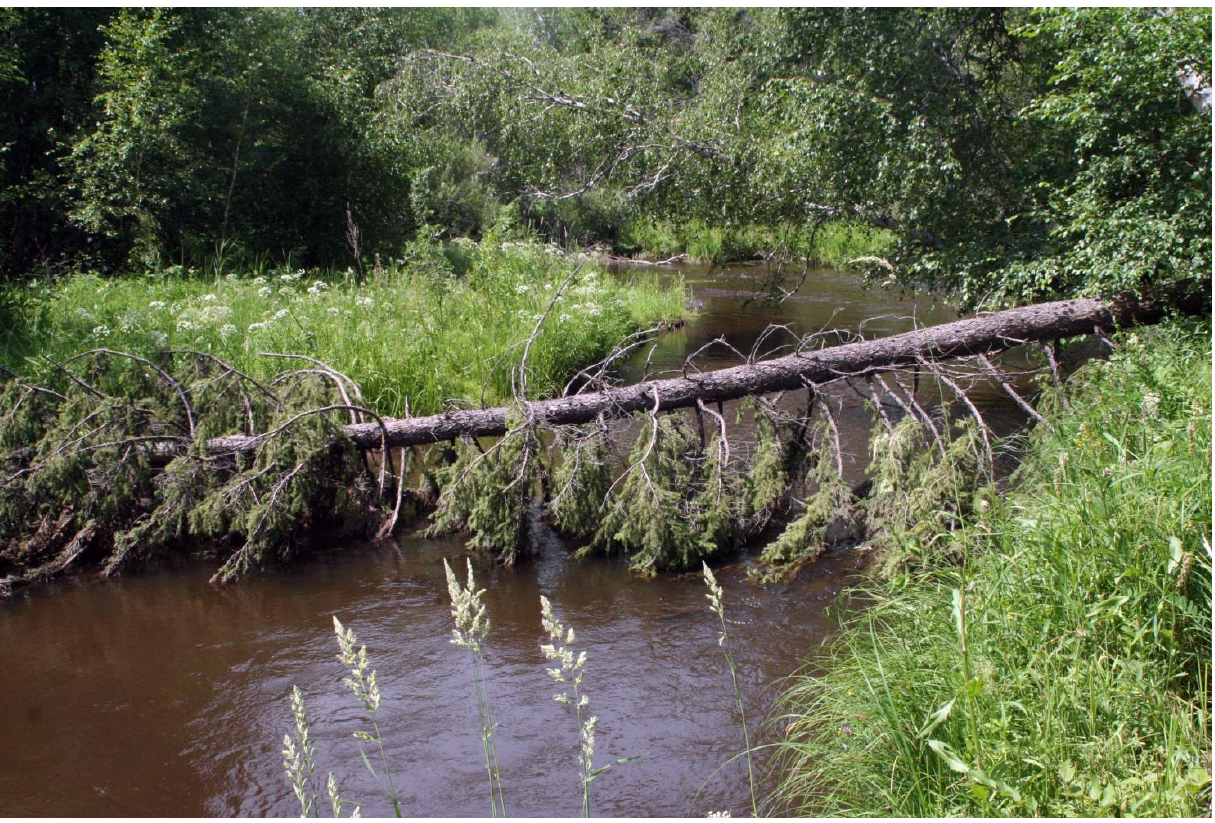
Fig. 1. Uyuk River. Piy-Khem Kozhuun, 30 June 2017.